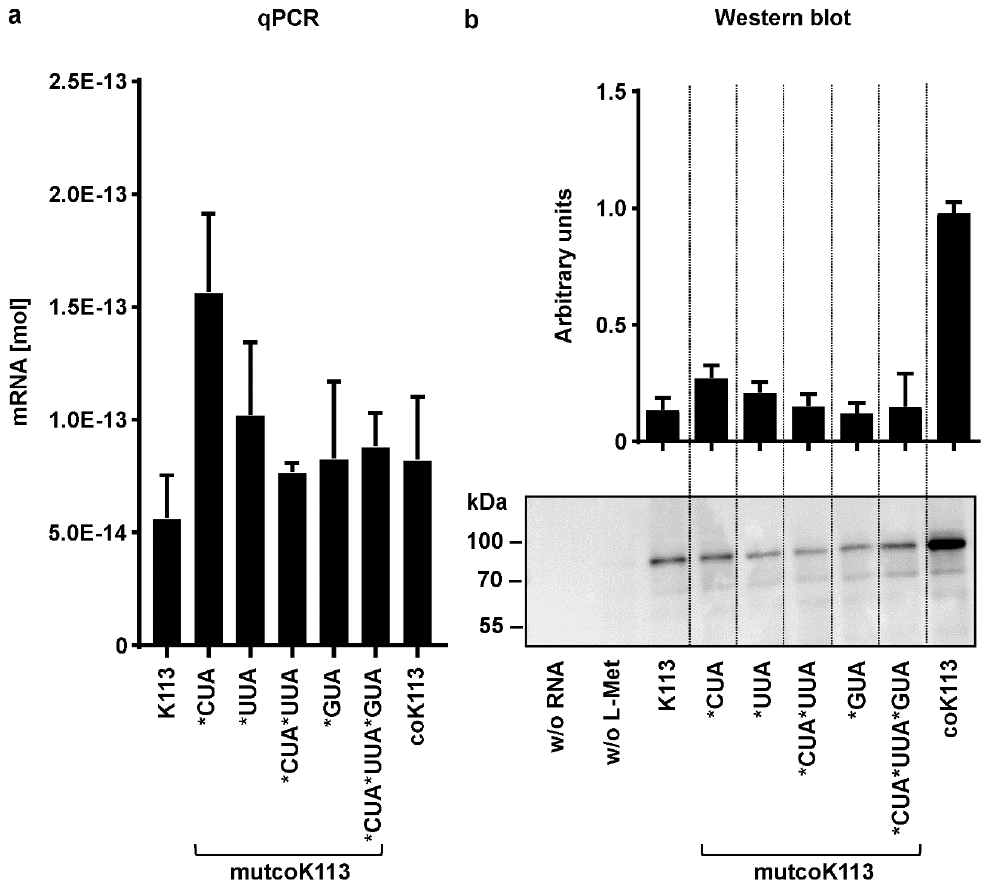
Figure 7. Cell-free expression of HERV-K113 envelope variants in qRT-PCR and Western blotting analysis. K113 envelope sequences of native (K113), codon-optimized (coK113), or its mutants with rare codons (mutcoK113) were in-vitro transcribed into mRNA and then translated into protein in a cell-free expression system. Mean and standard errors were calculated from at least two (four of native and codon-optimized K113 envelope) individual experiments with GraphPad Prism5. ( a ) In total, 1 µg of linearized expression vector DNA was used for generation of mRNA by transcription starting at T7 promotor site upstream of ENV by RNA polymerase. A total of, 1 µg of mRNA was reverse transcribed into cDNA and used as template in qRT-PCR. The calculation of absolute mRNA levels was performed using standard curves with native or codon-optimized vector DNA, respectively. ( b ) In total, 4 μg of transcribed mRNA of ENV in ( a ) were translated into protein using reticulocyte lysate from New Zealand white rabbits including a mixture of all components necessary for translation. A translation reaction without RNA and a sample of codon-optimized RNA without amino acid methionine (L-Met) served as negative controls. An equal aliquot of all reactions was loaded for Western blotting. Densitometric analysis was performed by using ImageJ software, n=4. The de-glycosylated precursor of K113 ENV was observed at 80 kDa using anti-HERV-K-TM (HERM1811-5) antibody.